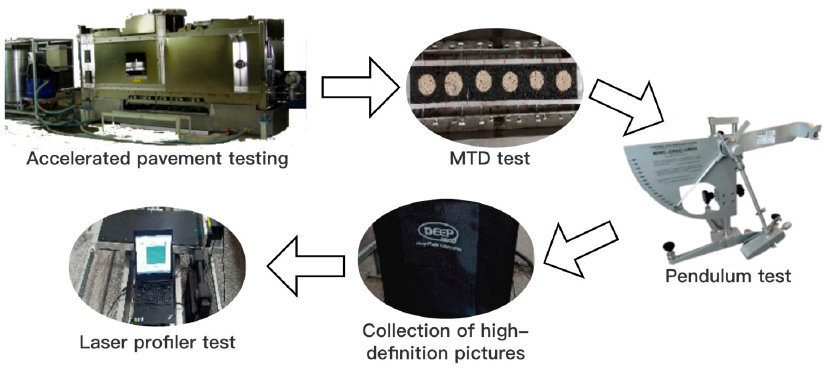
Figure 4. Data collection process.